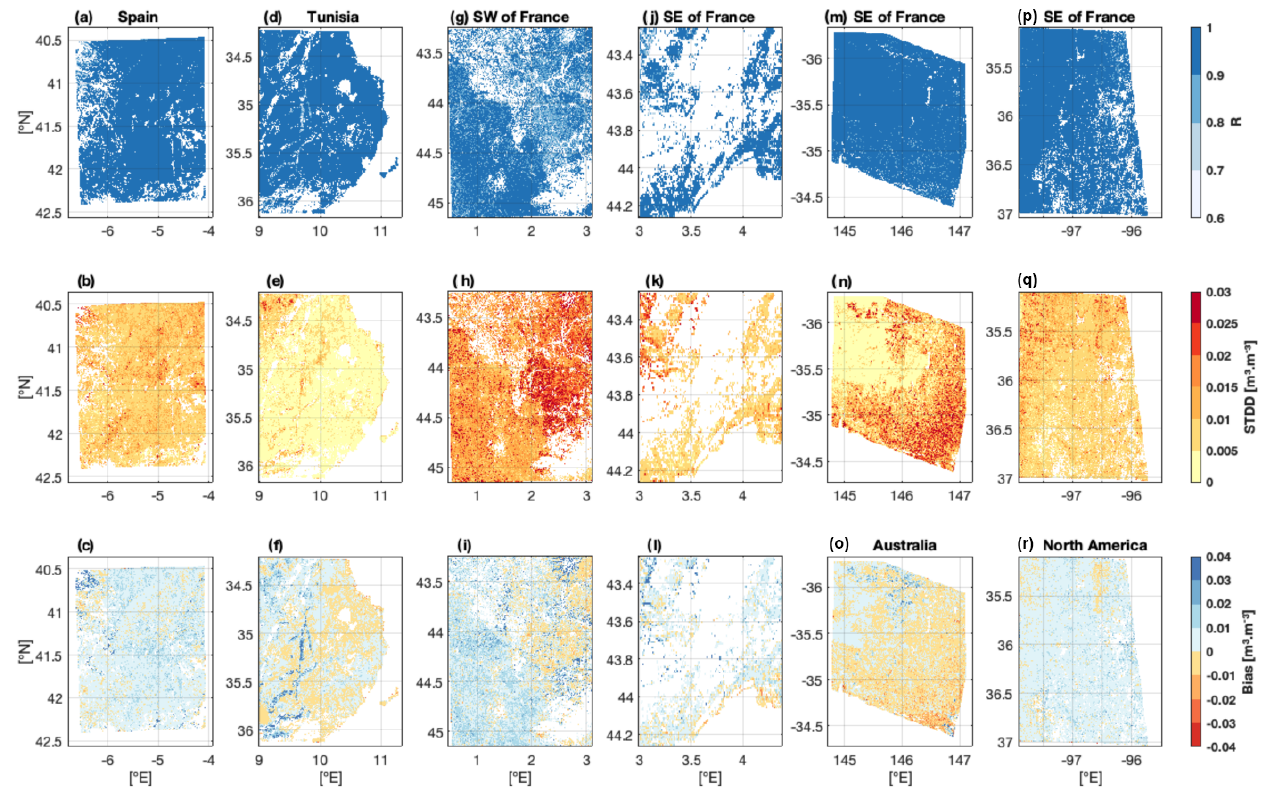
Figure 4. Comparison of S 2 MP S1S3 with respect to S 2 MP S1S2 over the regions of study in terms of Pearson correlation ( R ), bias (S 2 MP S1S2 minus S 2 MP S1S3 ), and standard deviation of the difference (SDD) in m 3 m − 3 . The analysis was performed from January to December